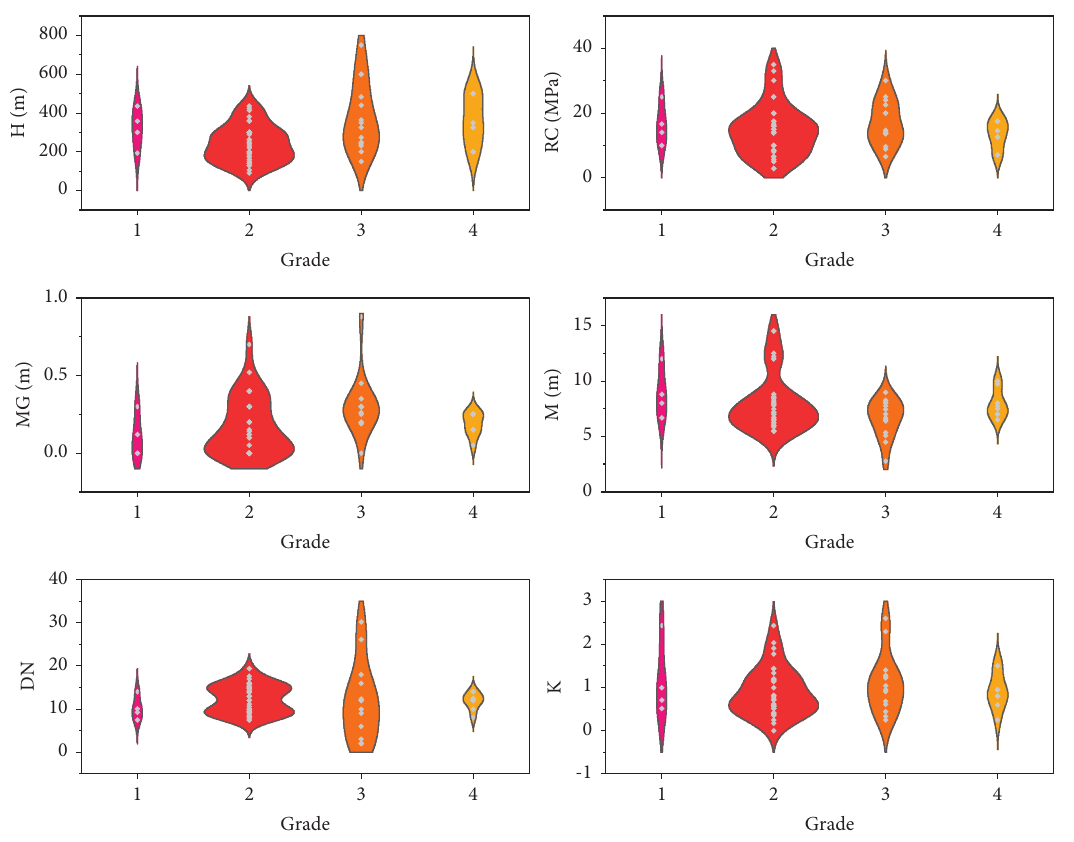
Figure 2: Distribution of sample